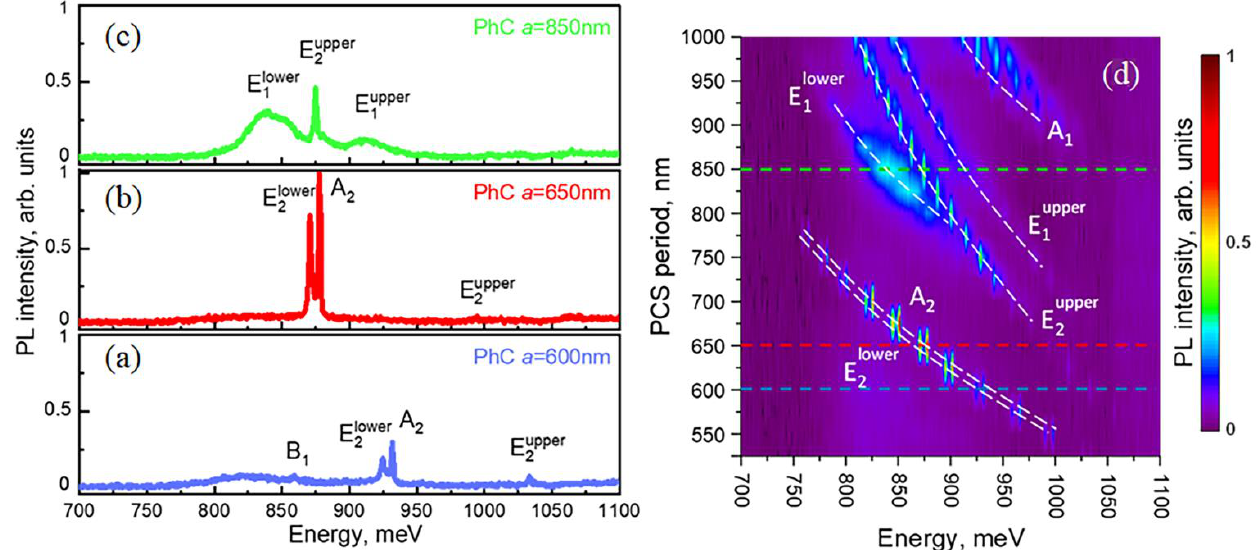
Figure 5. ( a – c ) — The spectra measured using the DPL setup with 2 Θ ~ 15° for PCSs with a = 600 nm ( a ), 650 nm ( b ) and 850 nm ( c ). ( d ) — 2D representation of DPL spectra as a function of energy and period of measured PCSs. The dashed lines of the corresponding color denote spectra of PCSs presented in figures ( a – c ) . The letters denote the PCS’s first order modes associated with the corresponding peaks in the DPL spectra (see also Figure 3). The unmarked luminescence signal in figure ( d ) in the energy range ≥ 950 meV for PCSs with a ≥ 900 nm is associated with the PCS’s second order modes.